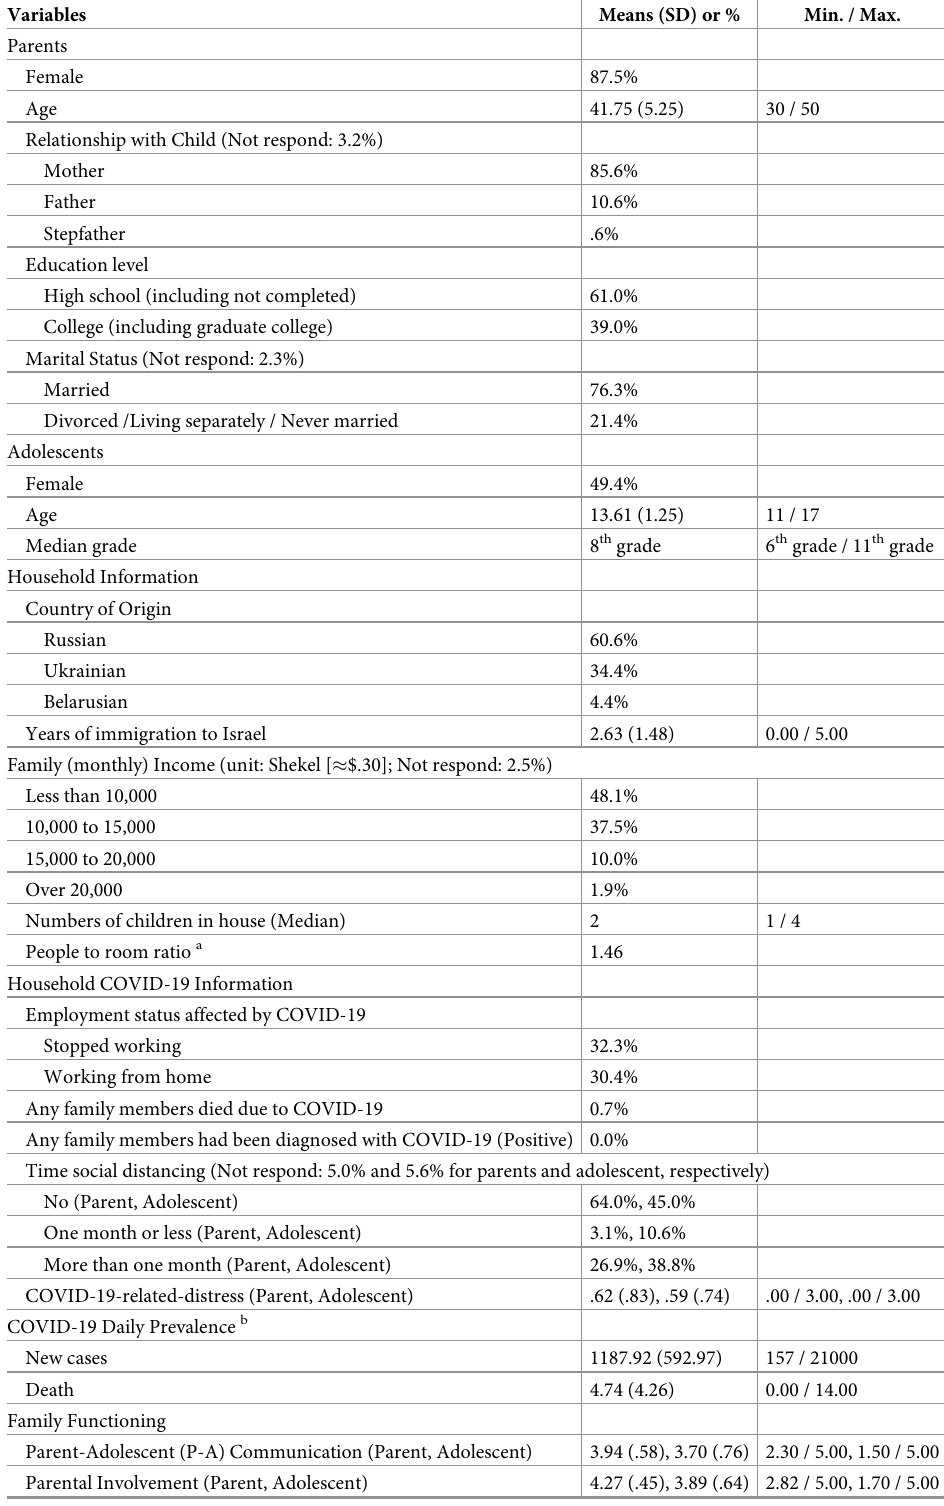
Table 1. Participants demographic information ( n =